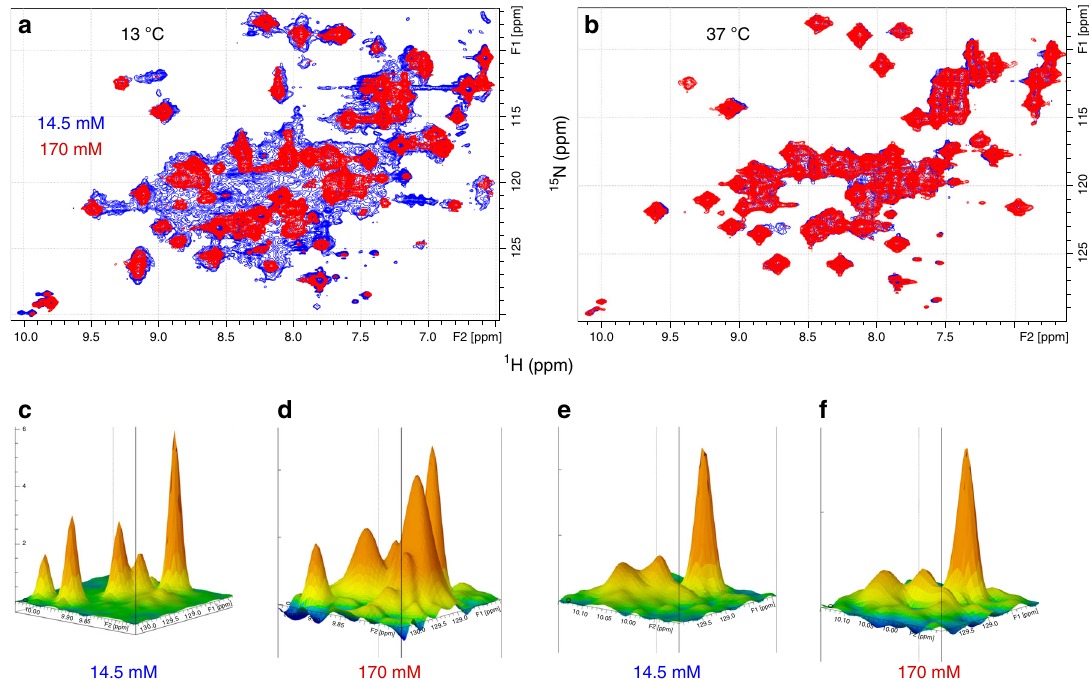
Fig. 2 Salt-temperature tunable structural heterogeneity. 1 H- 15 N HMQC spectra of Cnu at the indicated ionic strength conditions and temperatures 13 °C ( a , c , d ) and 37 °C ( b , e , f ). The panels in the bottom row represent the multiple resonances observed for the indole moiety of W67 located in the fourth